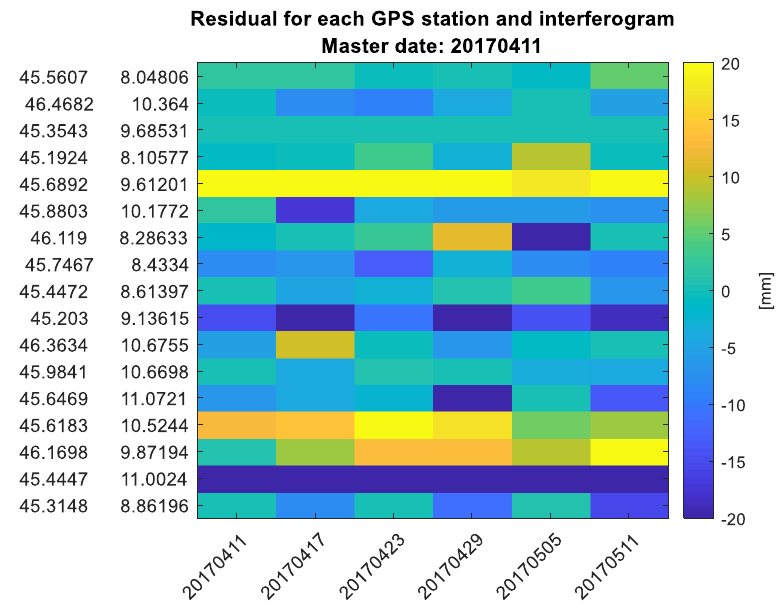
Remote Sens. 2019 , 11 , x FOR PEER REVIEW Figure 11. GNSS residuals for each station in the scene and for each interferogram.